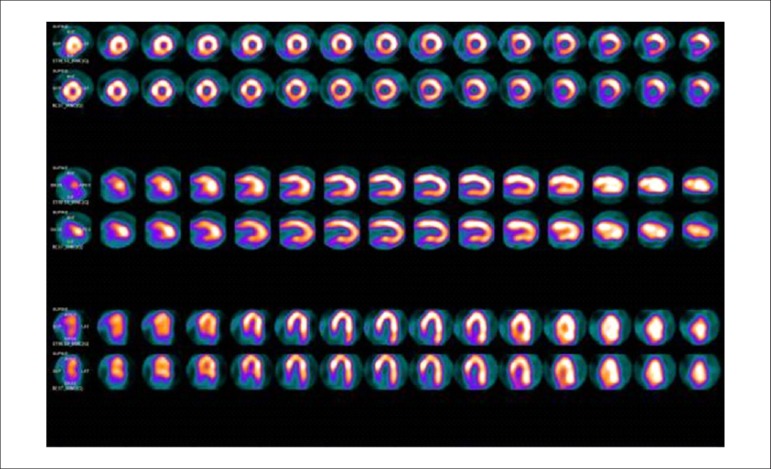
Case 4 - Myocardial perfusion scintigraphy within normality. Images acquired with dedicated cardiac equipment, equipped with solid cadmium-zinc-tellurium detectors.